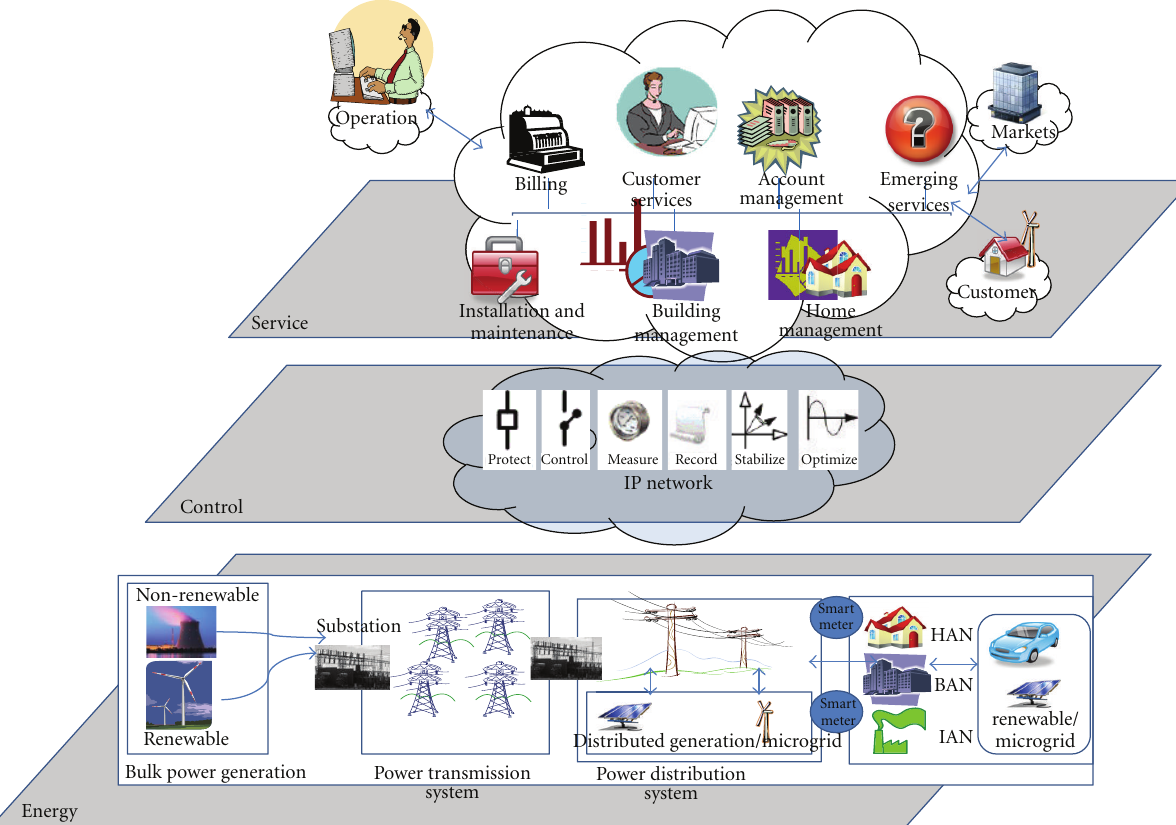
Figure 3: ETSI board of directors view on smart grid architecture including M2M network (adapted from